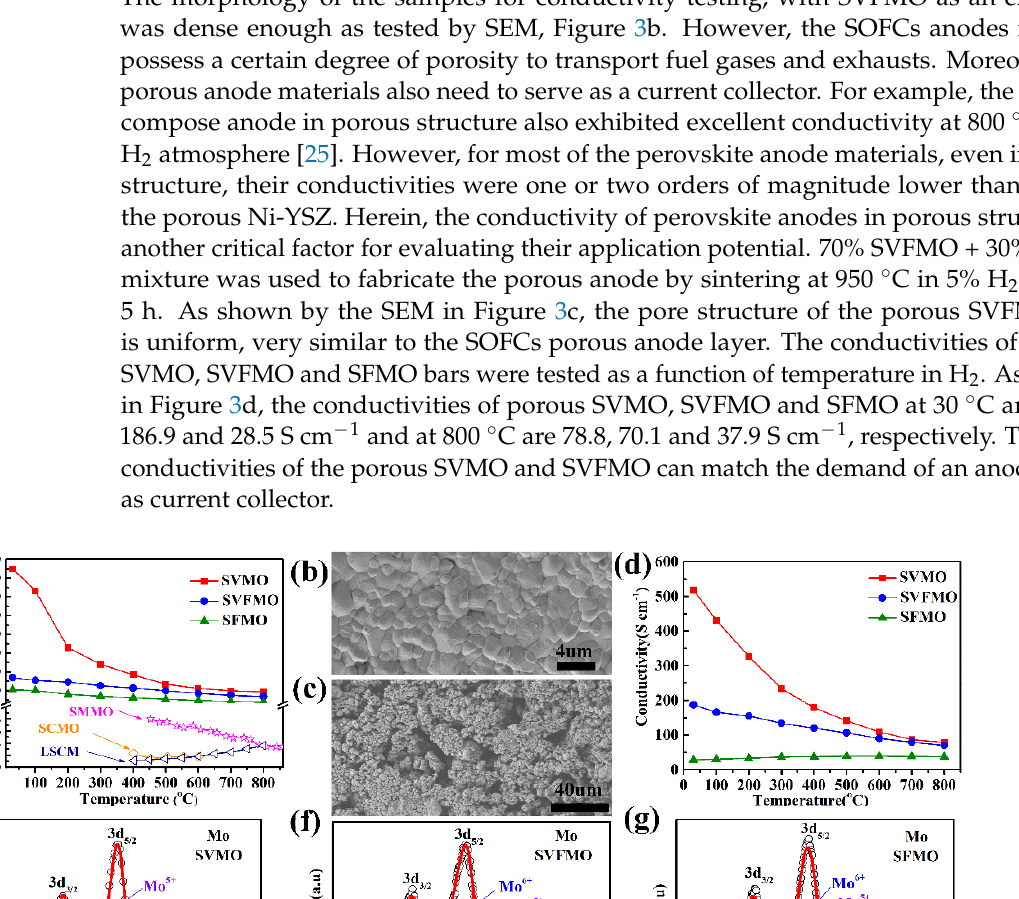
39%) to SVFMO (V 5+ in 47%), which is mainly attributed to the co-doping of low-valence and Fe 3+ . Fe 2+ and Fe 3+